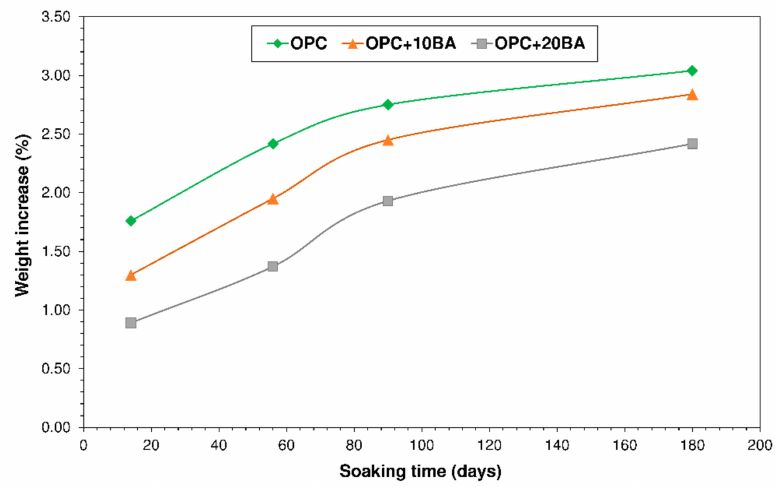
Figure 3. Variation in weight with time soaked in Na 2 SO 4